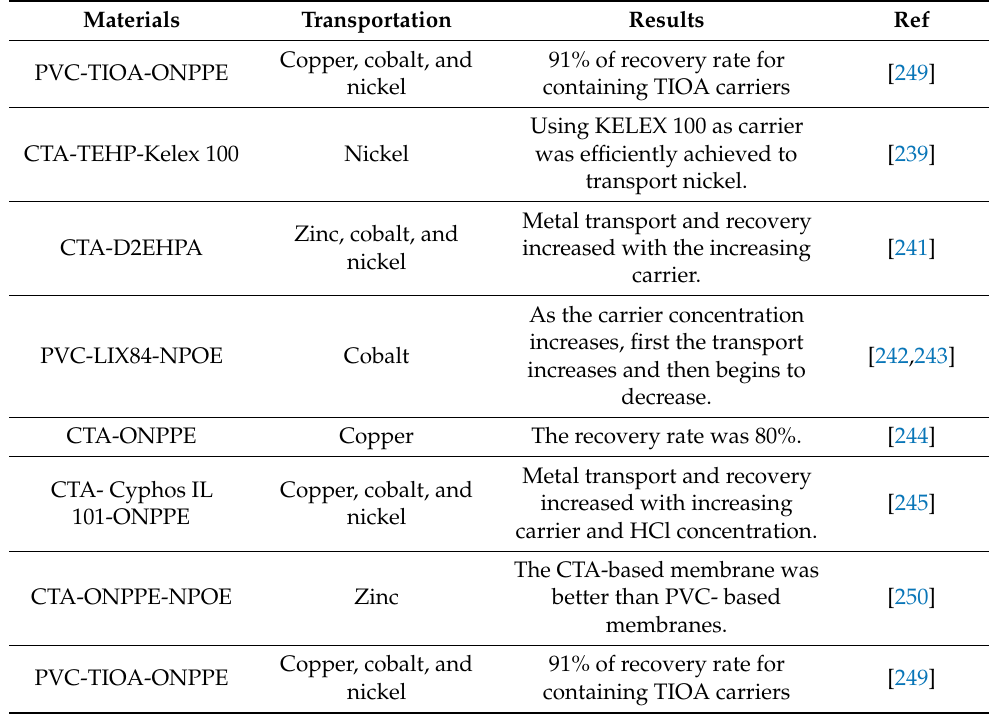
Table 13. BIM performance and results [237]. Reproduced with permission from Keskin, B.; Zeytuncu- Göko˘glu, B.; Koyuncu, I, Chemosphere; published by Elsevier,